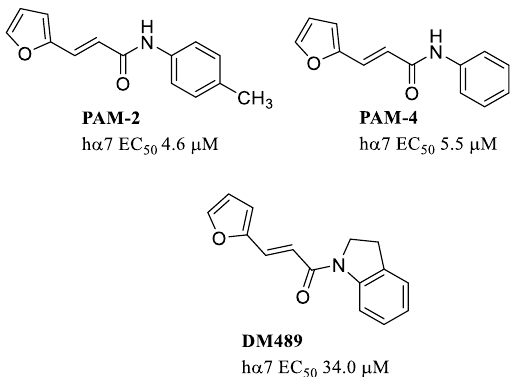
Figure 8. Examples of PAMs with an amide function.